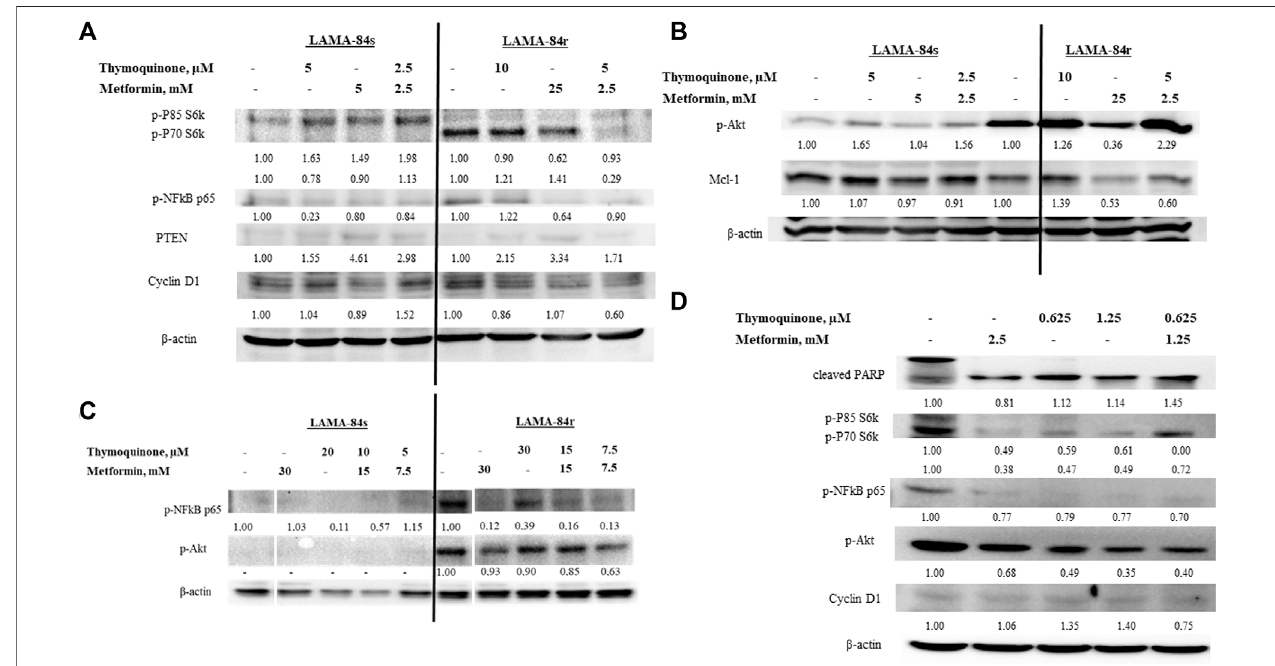
FIGURE4| Westernblotofcelllysatesfrom (A) LAMA-84sand (B) LAMA-84rcellstreatedfor48 hwithmetformin(M),thymoquinone(TQ),andtheircombinations, (C) LAMA-84s and LAMA-84r cells treated for 48 h with metformin, TQ, and their combinations with 1 µM doxorubicin pretreatment for 48 h, and (D) primary CLL cells treated for 48 h with metformin, TQ and their combinations. Numbers represent fold change compared to control. Abbreviations: myeloid cell leukemia-1 (Mcl-1); phosphorylated Akt(p-Akt); Poly(ADP-ribose)polymerase (PARP);phosphorylatedNF- κ B(p-NF- κ B);Phosphatase andtensinhomolog(PTEN);phospho-p85 S6 kinase (p-P85 S6k); phospho-p70 S6 kinase (p-P70 S6k); phosphorylated protein kinase C